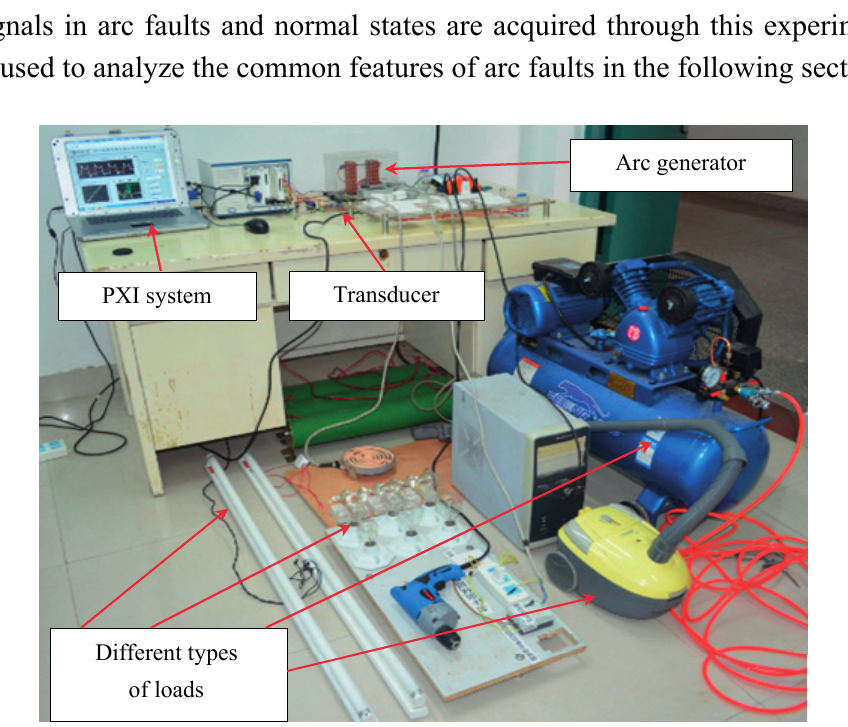
Figure 1. Experimental platform of arc